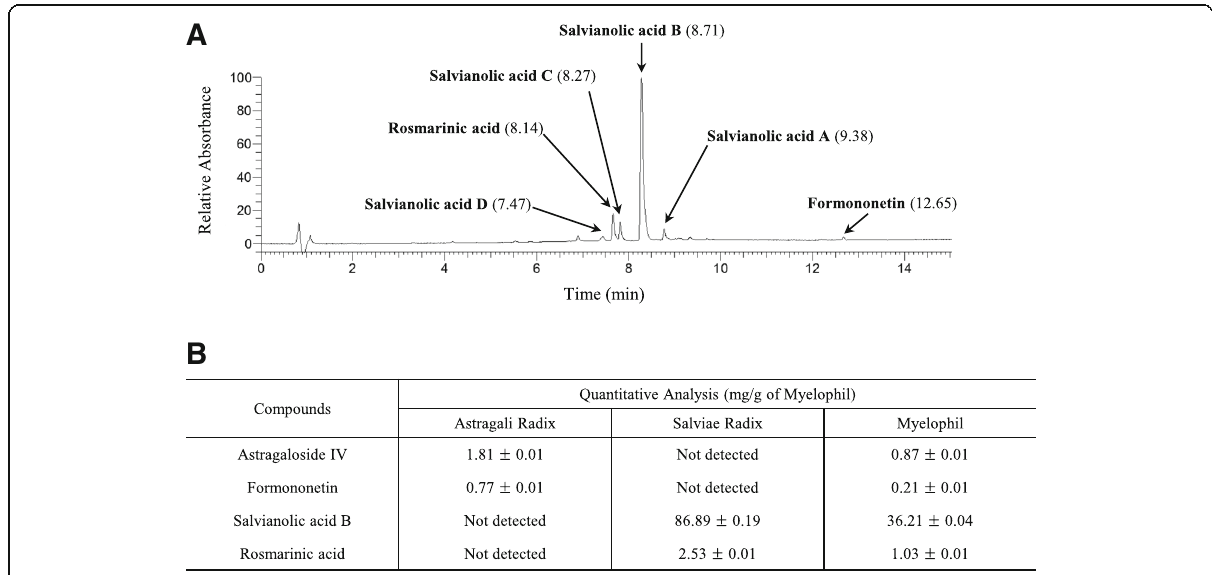
Fig. 1 UHPLC and LC/MS chromatogram of Myelophil. Myelophil and reference compounds were subjected to UHPLC analysis ( a ). Myelophil and four major compounds (Astragaloside IV and Formononetin for Astragali radix and Salvianolic acid B and Rosmarinic acid for Salviae Miltiorrhizae radix ) were quantified by LC/MS ( b